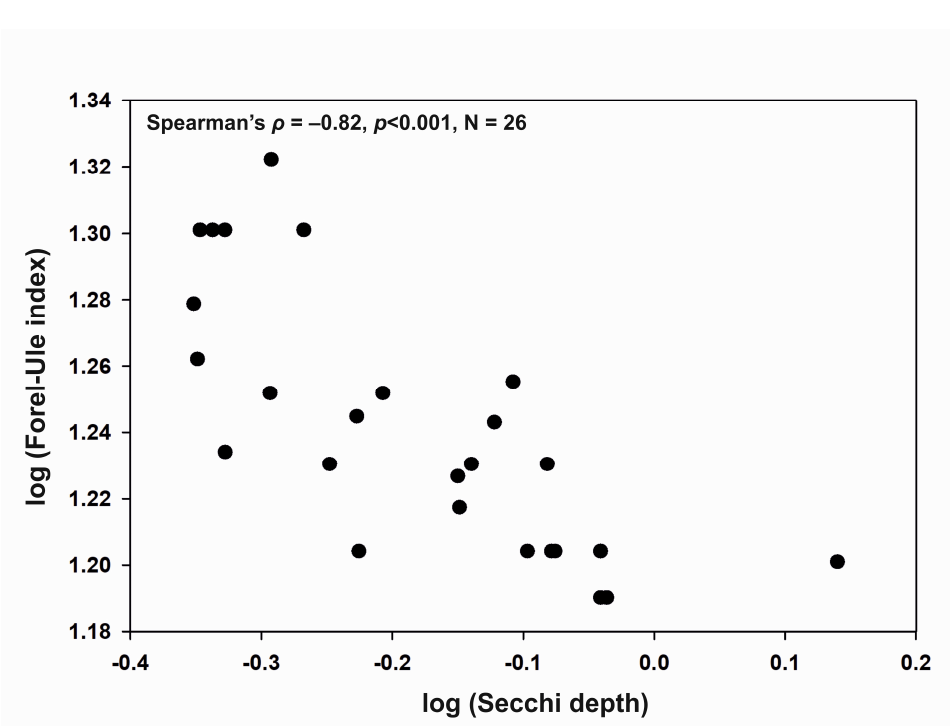
Figure 3. Spearman’s rank correlation test statistics from weekly averaged FU Index and Secchi depth of the 7 stations during the 5 weeks after demolition. One outlier ( − 1.1 log SD and 1.26 log FU) was removed from the samples (N =